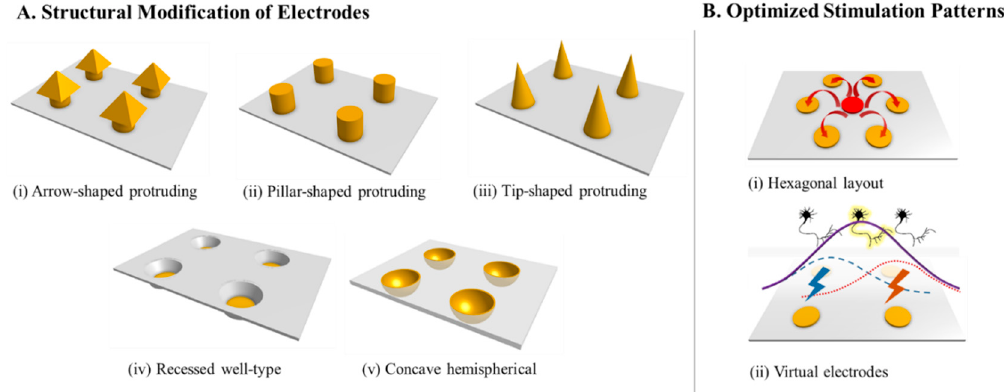
Figure 2. Schematic illustration of ( A ) featured retinal electrode structures for higher visual resolution including arrow-shaped, pillar-shaped, tip-shaped, recessed well-type, and concave hemispherical, and ( B ) optimized stimulation patterns based on hexagonal layout and virtual electrodes for current focusing and steering. (Adapted from